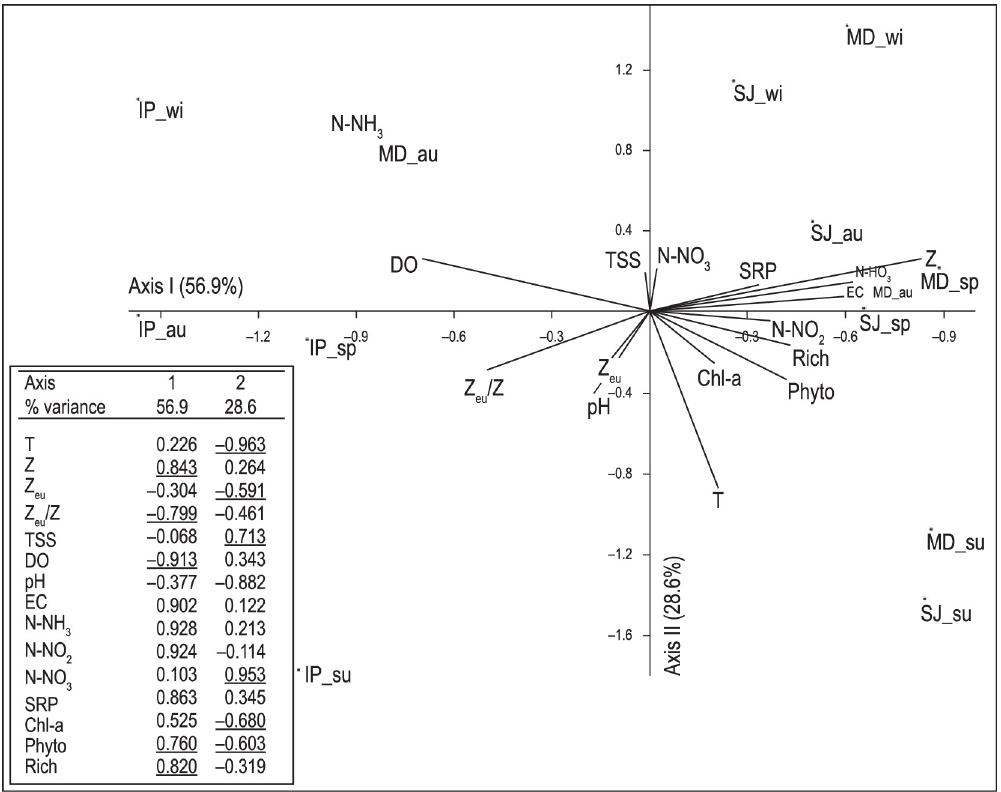
Figure 4. Biplot of seasonal units at the IP, SJ and MD sites and variable vectors on the first two PCA axes; su – sum- mer; sp – spring; wi – winter; au- autumn; in box: underlined numbers p <0.05, bold numbers p <